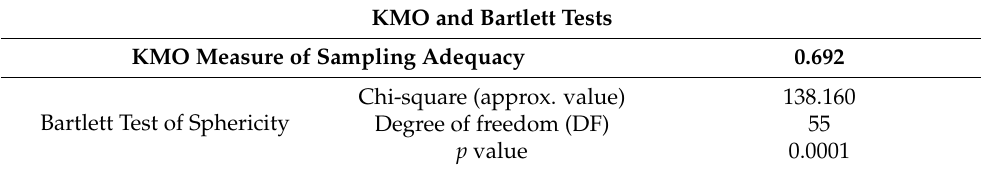
Table 2. The Kaiser–Meyer–Olkin (KMO) and Bartlett sphericity tests.